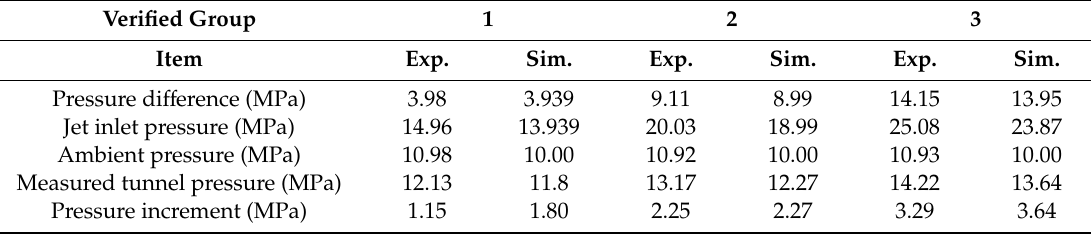
Table 1. The verification between the numerical results and He’s experiments [17].